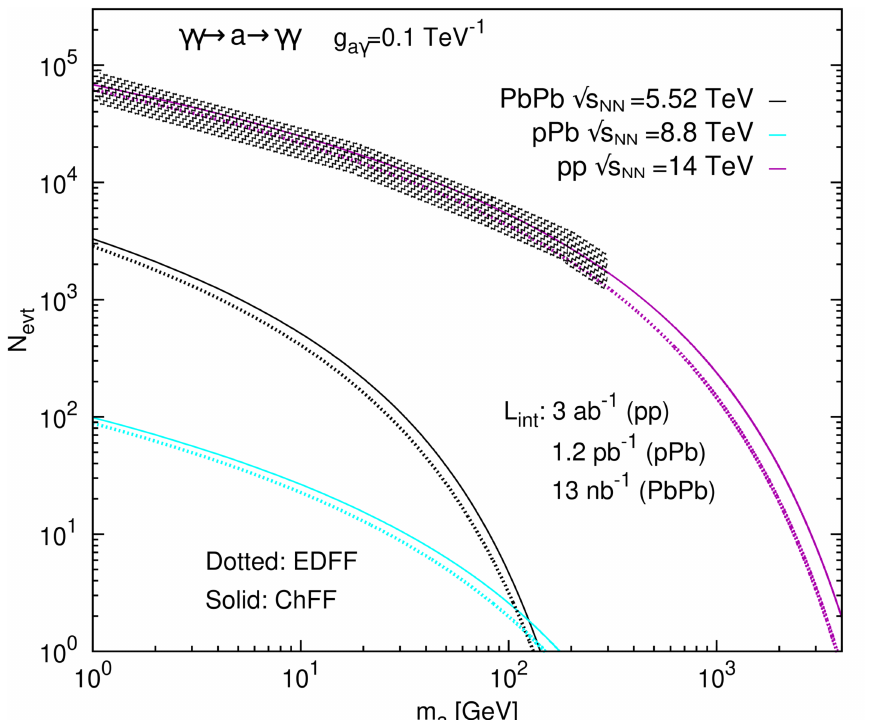
Figure 6 . Total number of ALPs events expected via (cid:13)(cid:13) ! a ! (cid:13)(cid:13) in p-p, p-Pb, and Pb-Pb UPCs at the LHC as a function of ALP mass, for fixed ALP-photon coupling g a (cid:13) = 0 : 1 TeV (cid:0) 1 (approximately corresponding to the current experimental limits over this mass range [139]) computed with EDFF (dotted) and ChFF (solid) (cid:13) fluxes. The hatched area around the p-p curve indicates the range of masses below m a (cid:25) 300 GeV where the detection is hindered due to pileup and lack of proton tagging